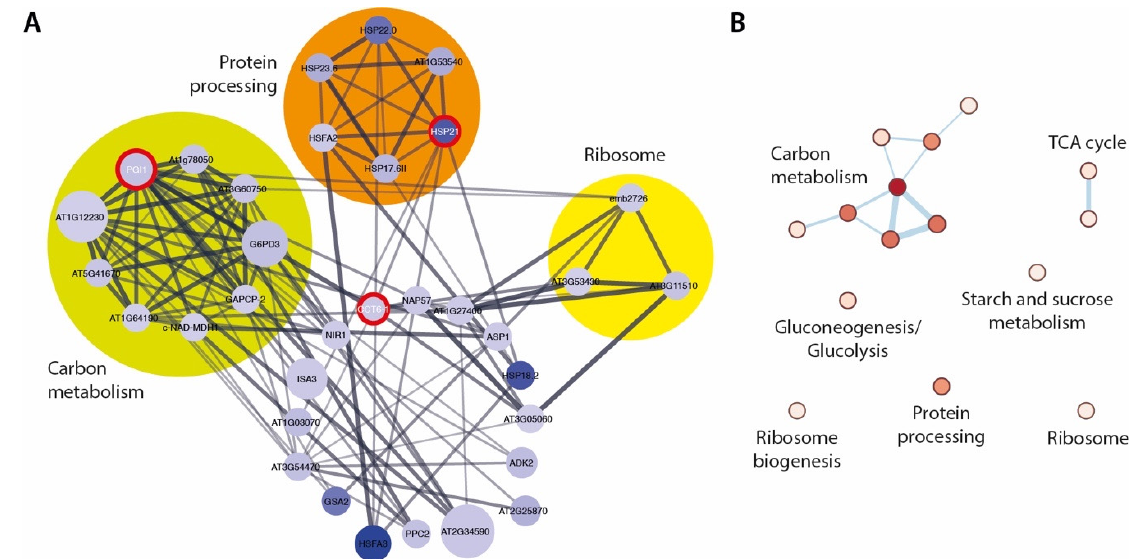
Figure 5. Network analysis of downregulated differentially expressed genes (DEGs) in ami1 rty . ( A ) Extracted network for the three DEGs with the highest betweenness centrality. The central hubs CCT6-1 , HSP21 , and PGI1 are highlighted by red circles. The nodes are color coded according to the log2FC expression levels of the DEGs (white to blue), with dark blue marking the most repressed DEGs. The node size describes the false discovery rate (FDR) values, while the edge thickness reflects the betweenness score between the nodes. Densely connected nodes have been identified by using the Molecular Complex Detection (MCODE) clustering algorithm and are highlighted by colored circles. ( B ) Kyoto Encyclopedia of Genes and Genomes (KEGG) pathway enrichment analysis of the sub-network extracted for CCT6-1 , HSP21 , and PGI1 . The color (white to red) gives account on the normalized enrichment score of the corresponding KEGG pathway.